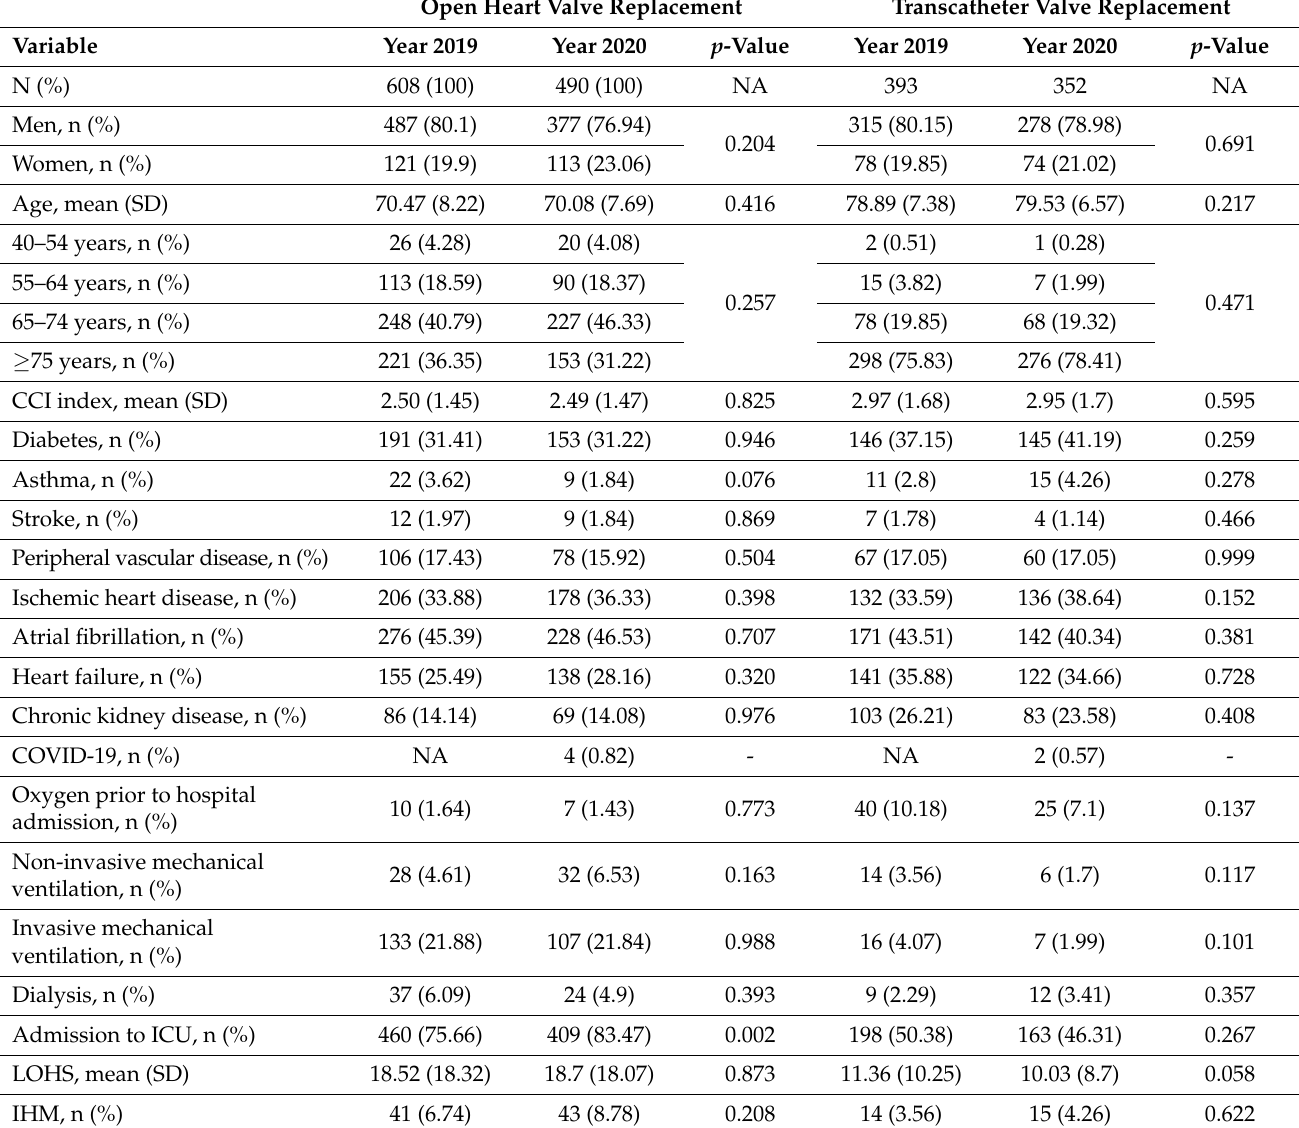
Table 3. Demographic and clinical characteristics and in-hospital outcomes of patients with chronic obstructive pulmonary disease who underwent open-heart valve replacement or a transcatheter valve implantation in Spain in 2019 and 2020. Analysis of the Spanish National Hospital Discharge